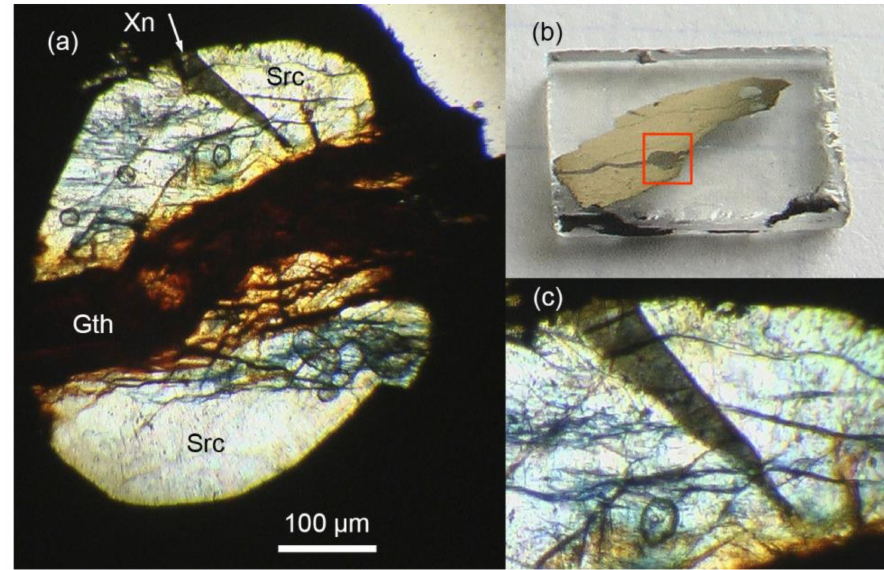
Figure 2. Xenophyllite in the Augustinovka meteorite. ( a ) A ~0.5 mm sarcopside grain cross-cut by secondary goethite and dissected with the green-grey xenophyllite lamella. Photomicrograph in transmitted light. ( b ) General view of troilite thin section containing phosphate assemblage depicted in Figure 1a (the field is outlined by the red square). ( c ) An enlarged view of xenophyllite lamella shown in Figure 1a. Photomicrograph in transmitted light. Abbreviations: Xn, xenophyllite; Src, sarcopside; Gth, goethite. Photographs by Sergey